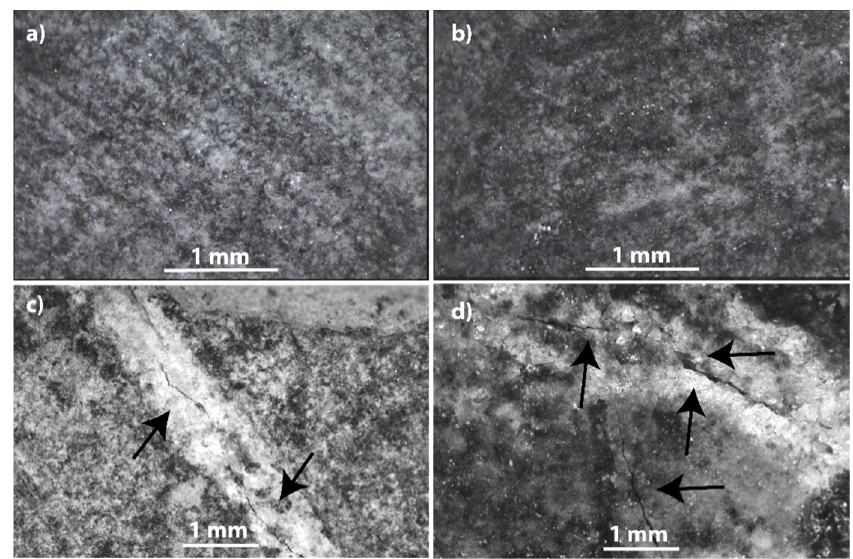
Figure 5. Images of the mineral thermally treated to temperatures of ( a ) 400 °C, ( b ) 600 °C, ( c ) 800 °C, and ( d ) 1000 °C.